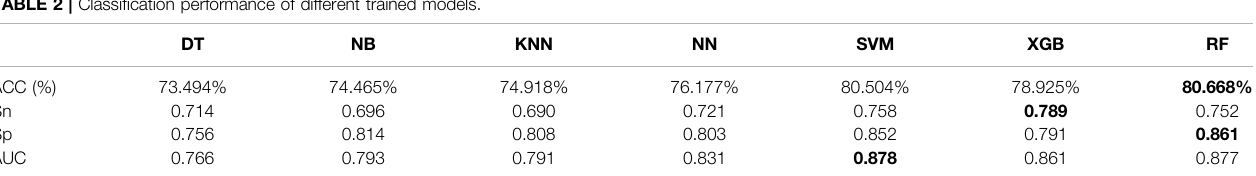
TABLE 2 | Classi fi cation performance of different trained